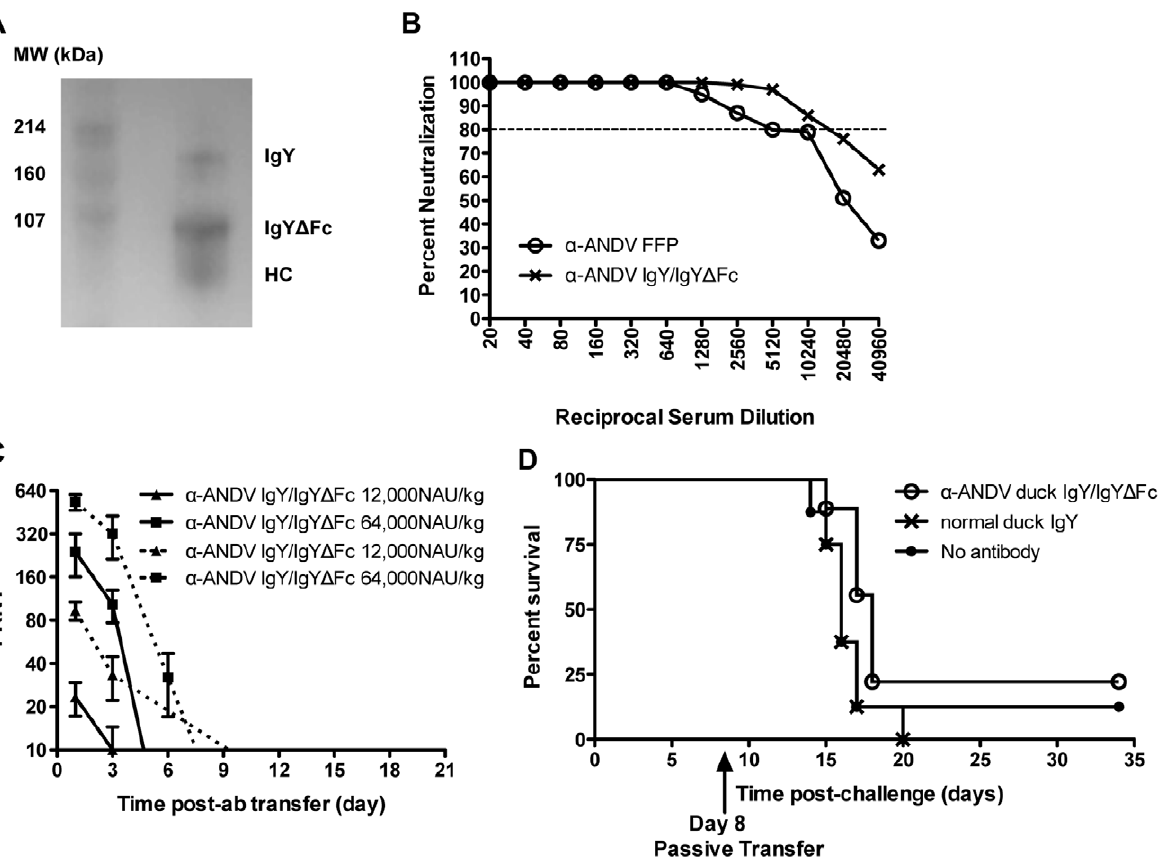
Figure 4. Neutralizing activity of a -ANDV duck IgY/IgY D Fc invitro and invivo . A) Western blot analysis of IgY components recognized by a - duck IgY antibodies. A) represents IgY/IgY D Fc by Western blot with SDS-PAGE run under non-reducing conditions and probed with an a -duck IgY antibody recognizing the heavy chain of both IgY and IgY D Fc. HC is the heavy chain of IgY. B) Percent neutralization of a -ANDV FFP and a -ANDV duck IgY D Fc measured by ANDV PRNT. Dotted line represents 80% neutralization (PRNT). C) Neutralizing antibody bioavailability was determined by ANDV PRNT performed on hamster serum samples collected after passive transfer of a -ANDV duck IgY D Fc (12,000 NAU/kg and 64,000 NAU/kg) by the s.c. route on day 0, through 21 days. PRNT 80 titers (solid lines) and PRNT 50 titers (dashed lines) are plotted. D) Survival curve of hamsters challenged with 4,000 PFU of ANDV i.n. on day 0 and passively transferred with 5,000 NAU/kg of a -ANDV duck IgY D Fc on day 8 postinfection.